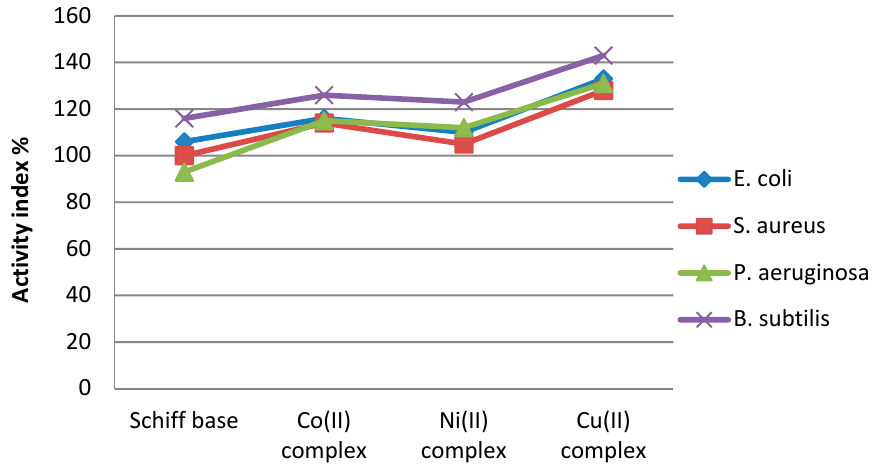
Figure 13. Activity index values of compounds.